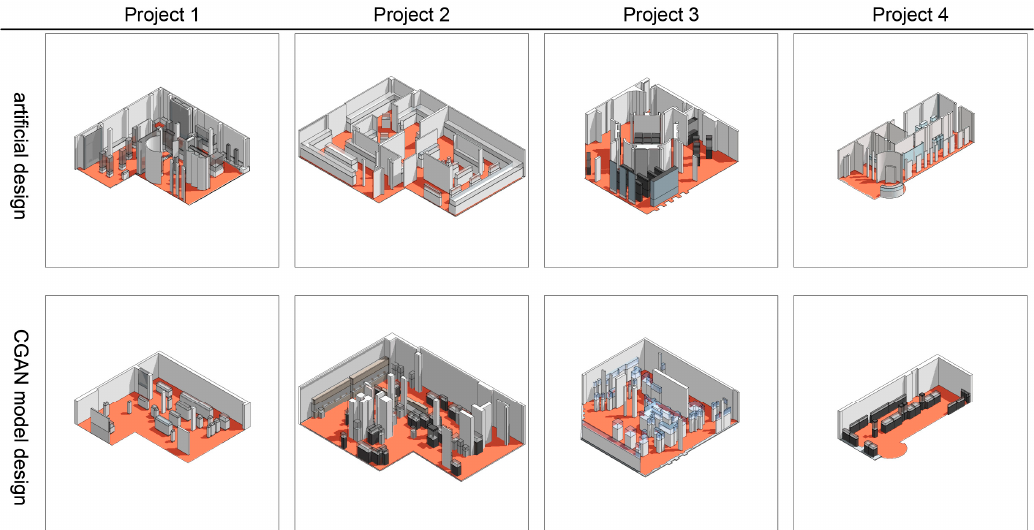
Figure 9. A 3D model comparison based on architect design and CGAN model design results.